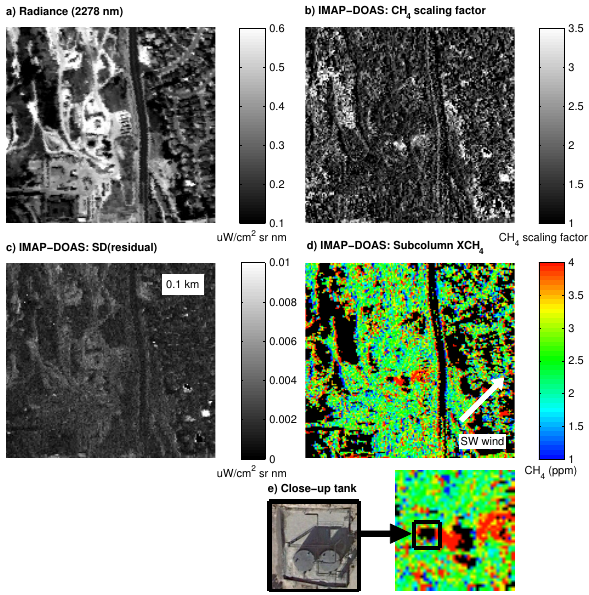
Fig. 8. (a) For location L1 (see Fig. 7), the measured radiance (black) indicates sensor saturation due to high sun glint between 2278 and 2328nm. This causes considerable disagreement with the modeled radiance (red), as indicated by the residual radiance shown in the bottom plot. (b) There is better agreement for location L2. (c) The radiance shown in (b) was detrended and the CH 4 Jacobian for the lowest layer overlain (green) to indicate the location of CH 4 absorptions at 2298, 2318, and 2348nm.